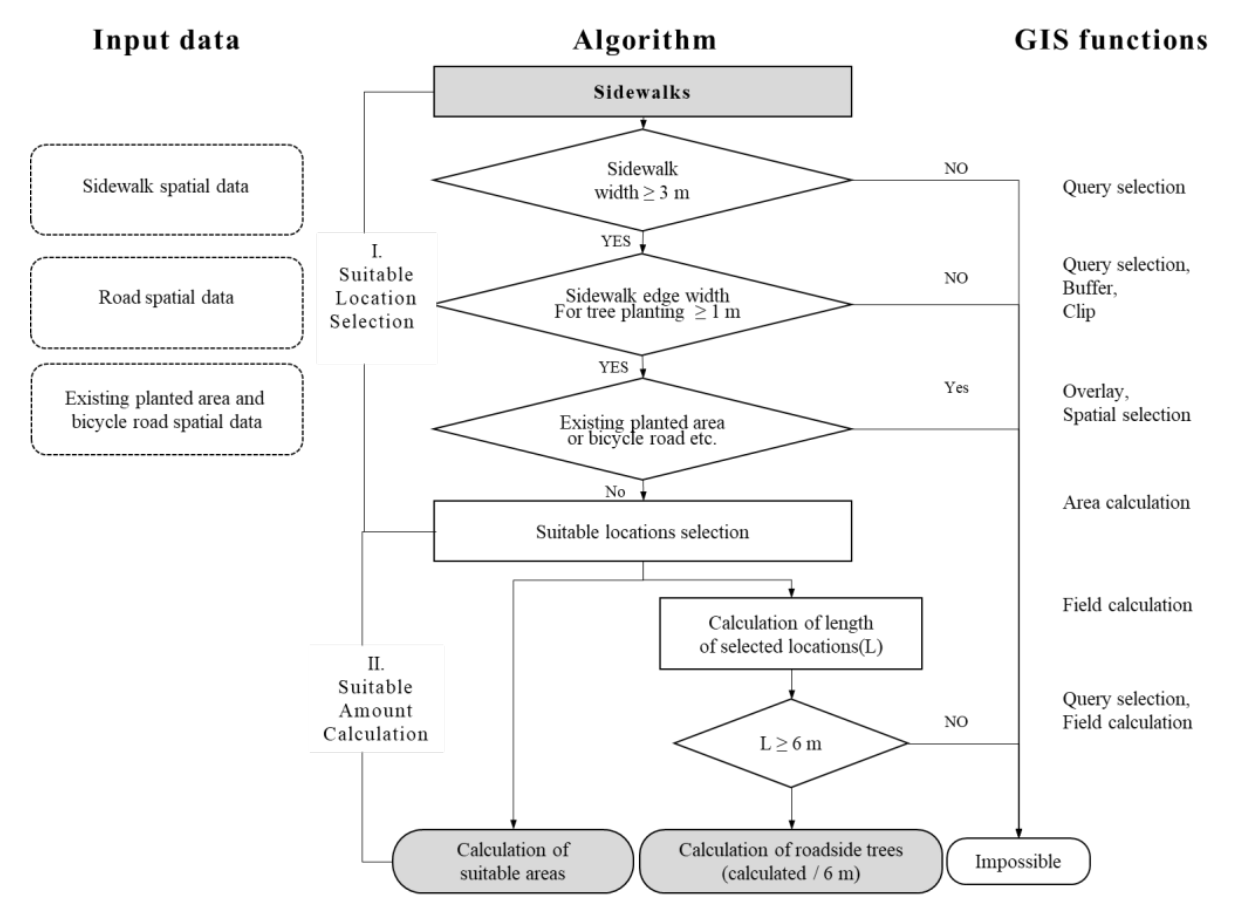
Figure 3. Algorithm for analyzing suitable locations for roadside tree planting.